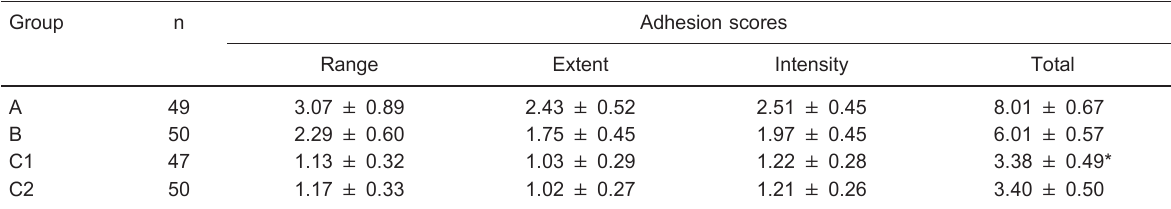
Group A, untreated; group B, treated with sodium carboxymethyl cellulose (SCMC) only; group C1, treated with SCMC ++ 3 mg dexamethasone, and group C2, treated with SCMC ++ 8 mg dexamethasone. *P , 0.05, group C1 compared with group B; *P , 0.01,